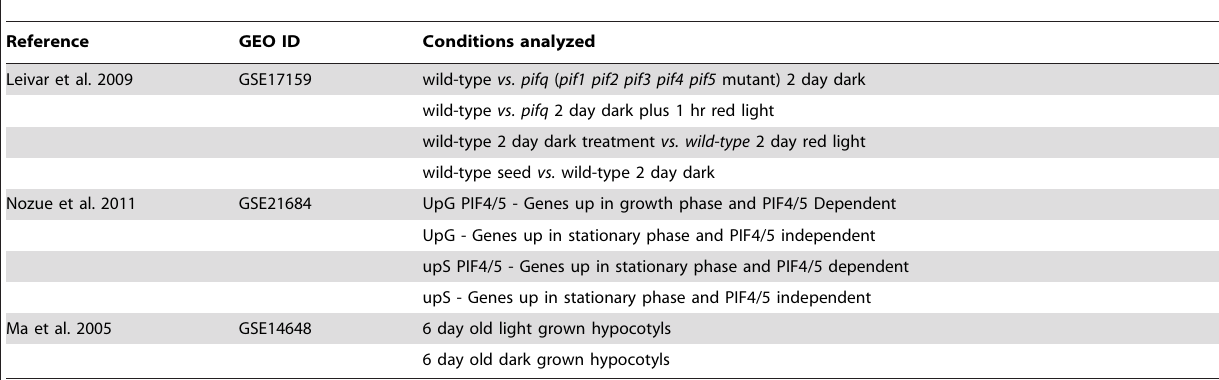
Table 1. Microarray data selected for comparison to auxin-regulated gene